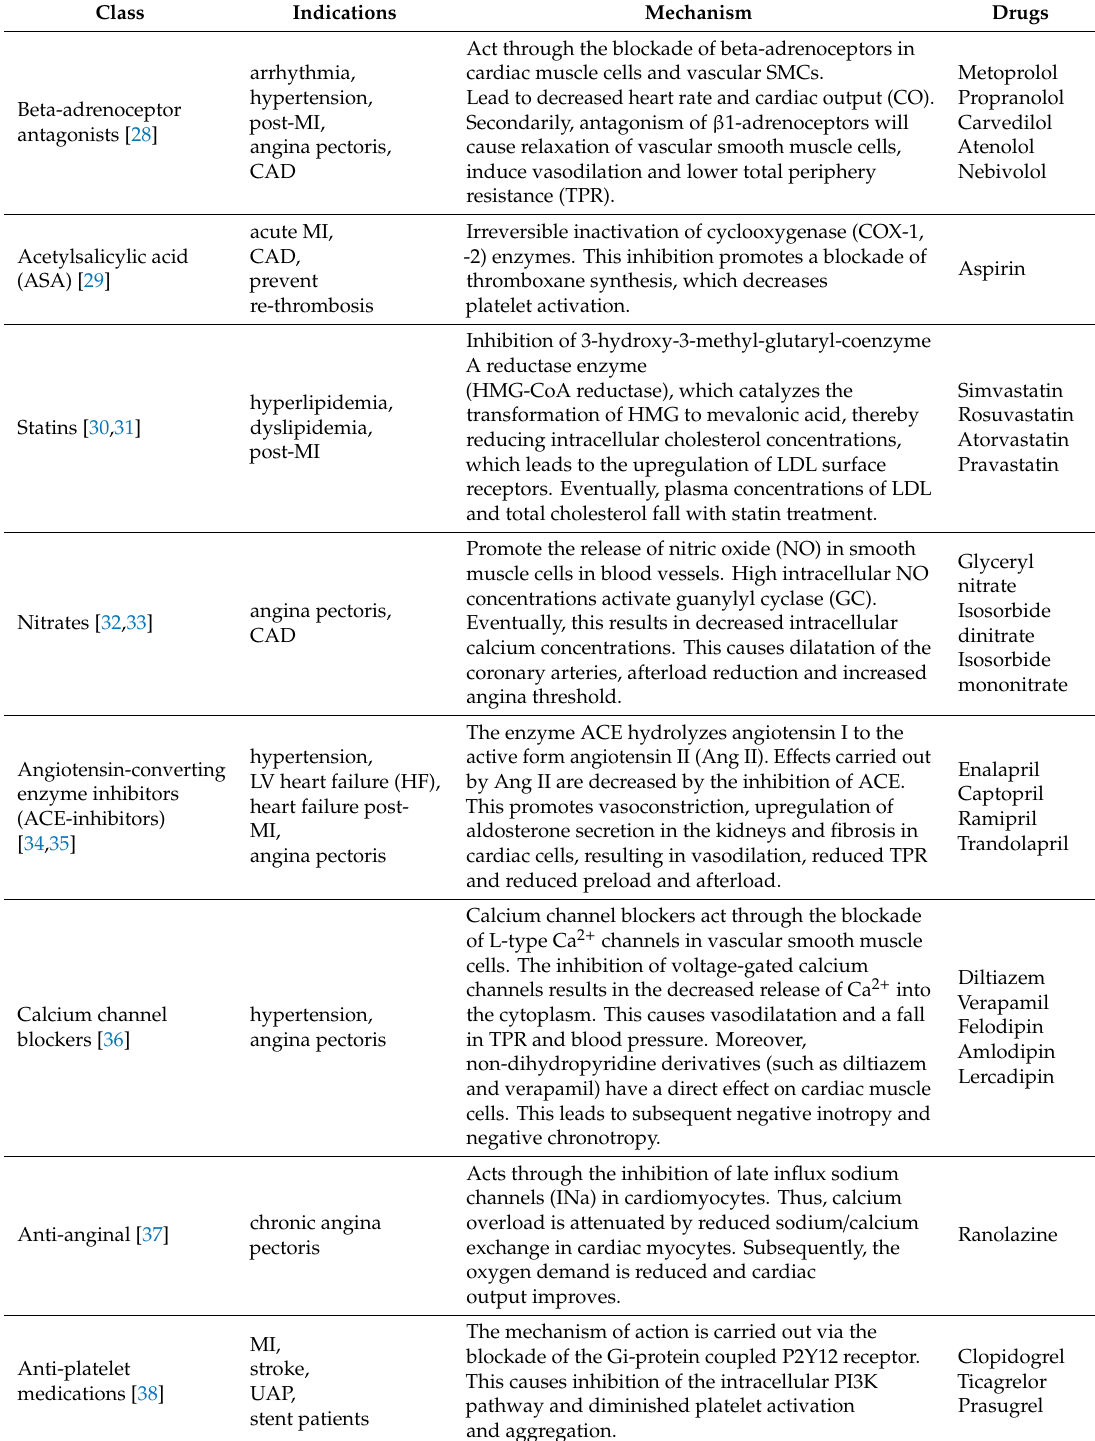
Table 3. Overview of medications used for